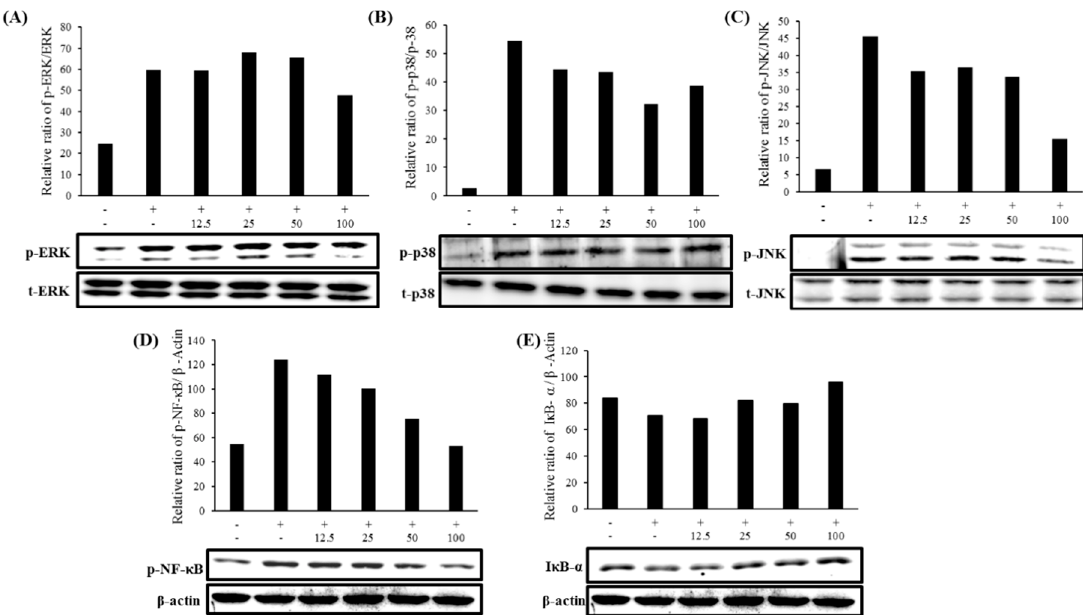
Figure 5. Effect of FMP on the protein levels of ( A ) extracellular signal-regulated kinase (ERK), ( B ) p38, ( C ) c-Jun N-terminal kinase (JNK), ( D ) nuclear factor kappa B (NF- κ B), and ( E ) I κ B kinase in LPS-stimulated RAW 264.7 cells. Cells (1.5 × 10 5 cell/mL) were stimulated with LPS (1 µg/mL) in the presence of FMP (12.5, 25, 50, and 100 µM) for 30 min. Whole-cell lysates (30 µg) were prepared, the protein level was subjected to 10% SDS-PAGE, and the expression of MAPK, NF- κ B and β -actin was determined by western blotting.